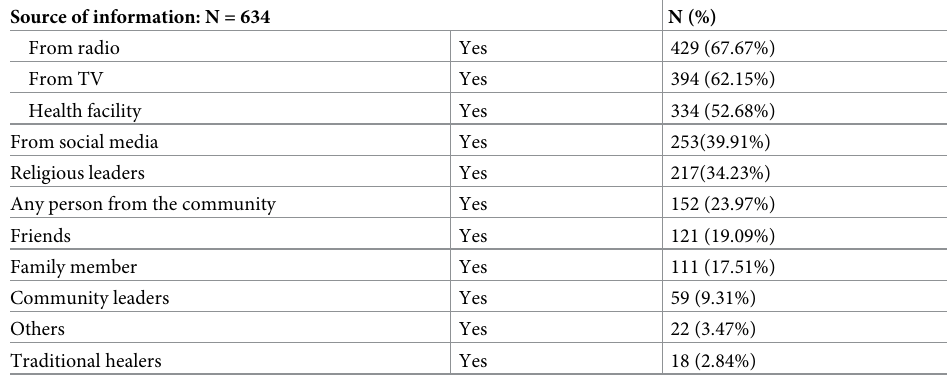
Table 3. Sources of information on COVID-19 in Qellam Wallaga Zone Oromia, Ethiopia,